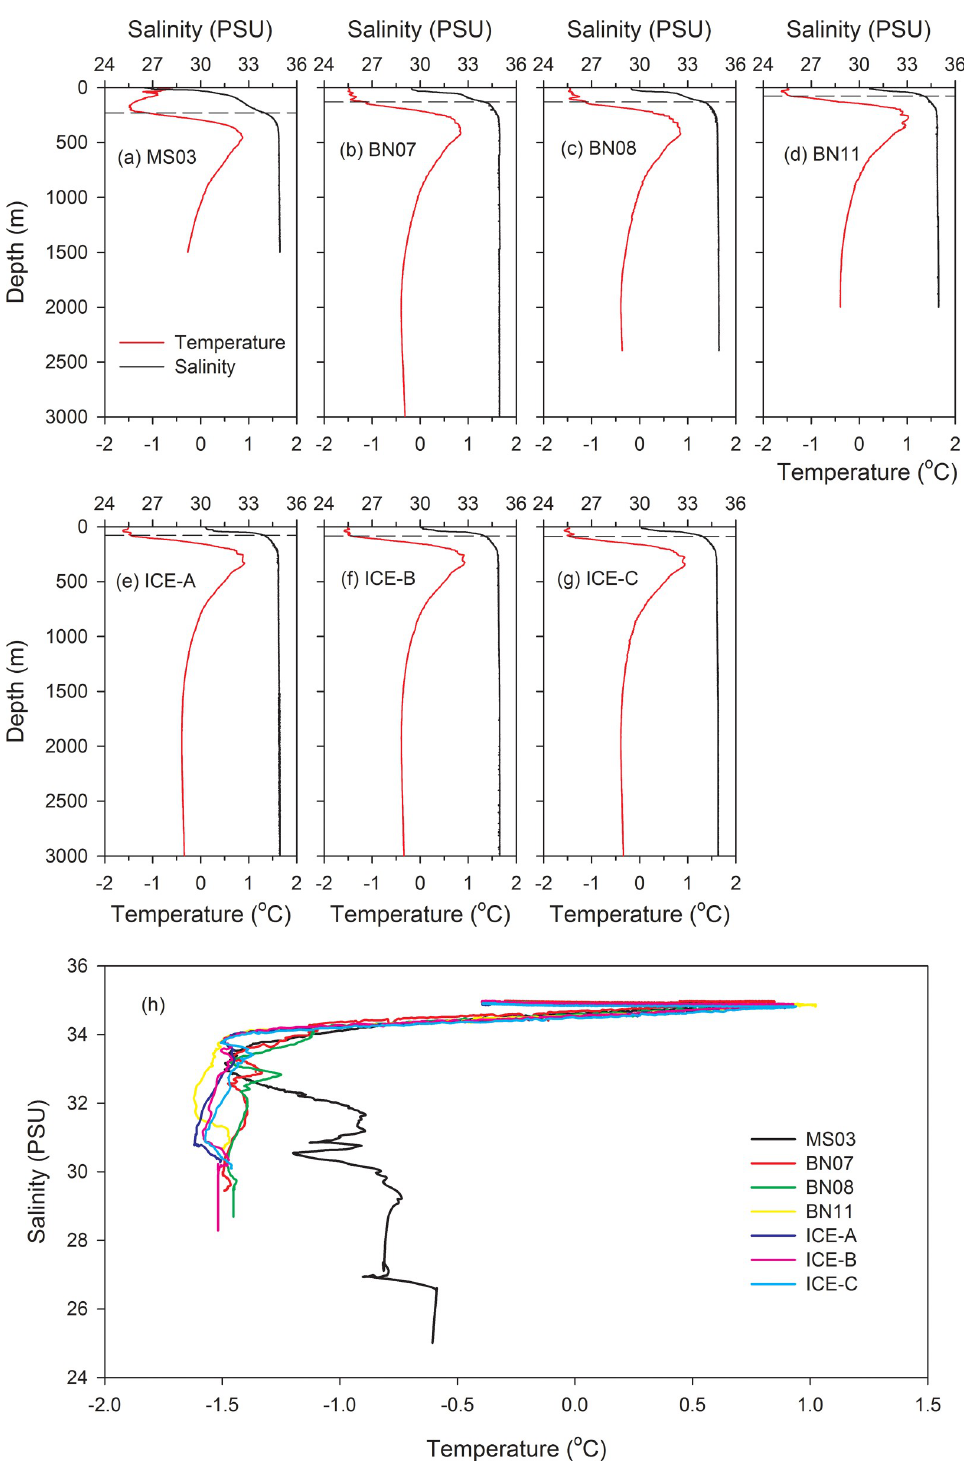
Fig 2. Temperature and salinity profiles above a depth of 3000 m at each sampling station. The curves were collected from stations (a) MS03, (b) BN07, (c) BN08, (d) BN11, and (e–g) ICE-A to ICE-C. Dashed lines indicate a depth of salinity of 34 PSU at each station (a–g). (h) Temperature (T) and salinity (S) of all sampling stations; the T–S diagram shows the distribution of T and S at each station.